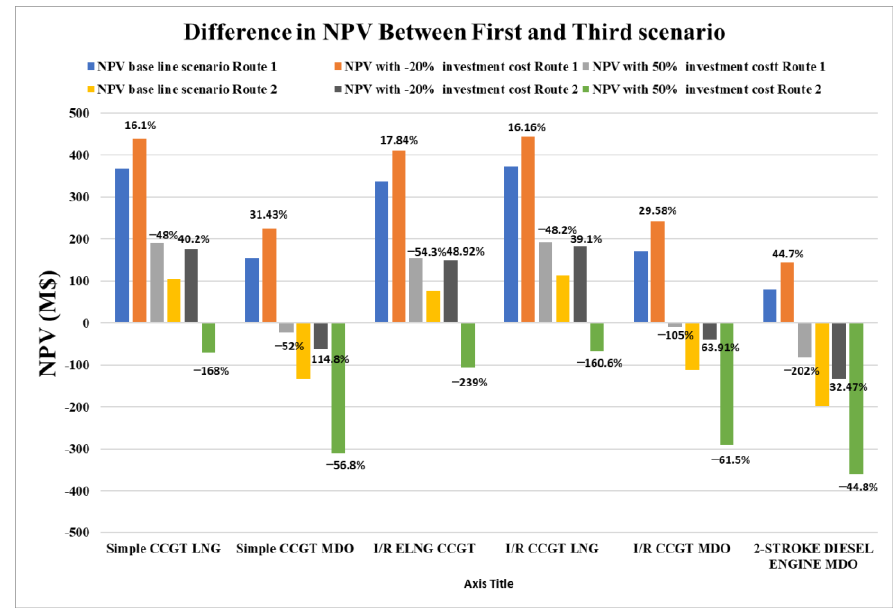
Figure 7. Difference in NPV between the first and third scenarios for Routes 1 and 2.